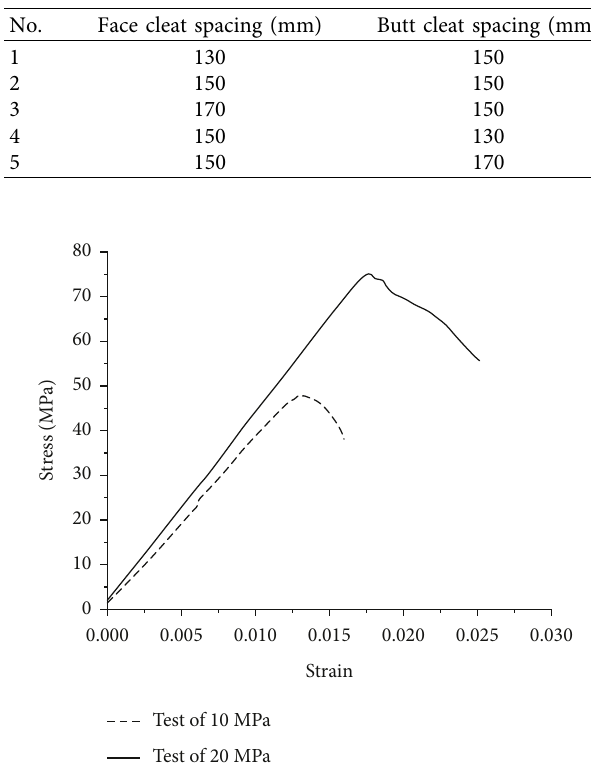
Table 2: Cleat spacing of coal.